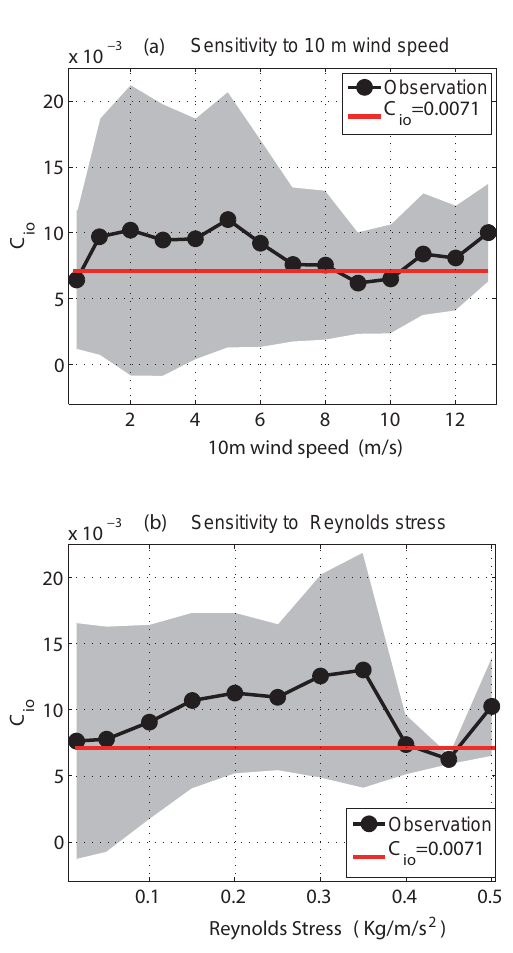
Figure A1. Sensitivity of the ice–ocean drag coefficient C io to (a) the surface wind speed (ms − 1 ) and (b) the surface stress (kgm − 1 s − 2 ), calculated using Eq. (A1). The black line shows the mean value calculated from ITP-V 35 observations and the gray shadings indicate the range of 1 standard deviation from the mean. The red line corresponds to the value estimated by Cole et al. (2014) based on least-squares